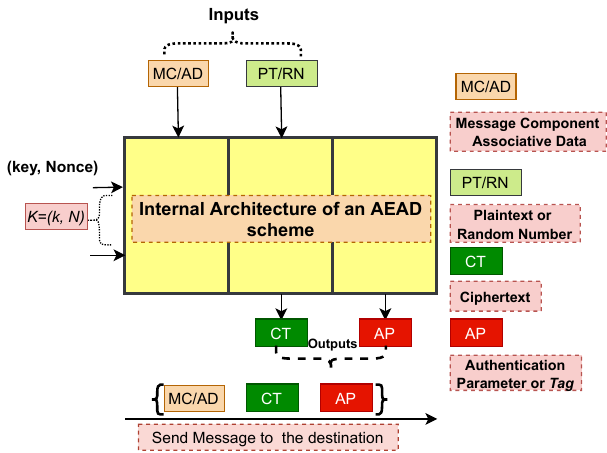
Figure 1. Message generation at source node using AEAD